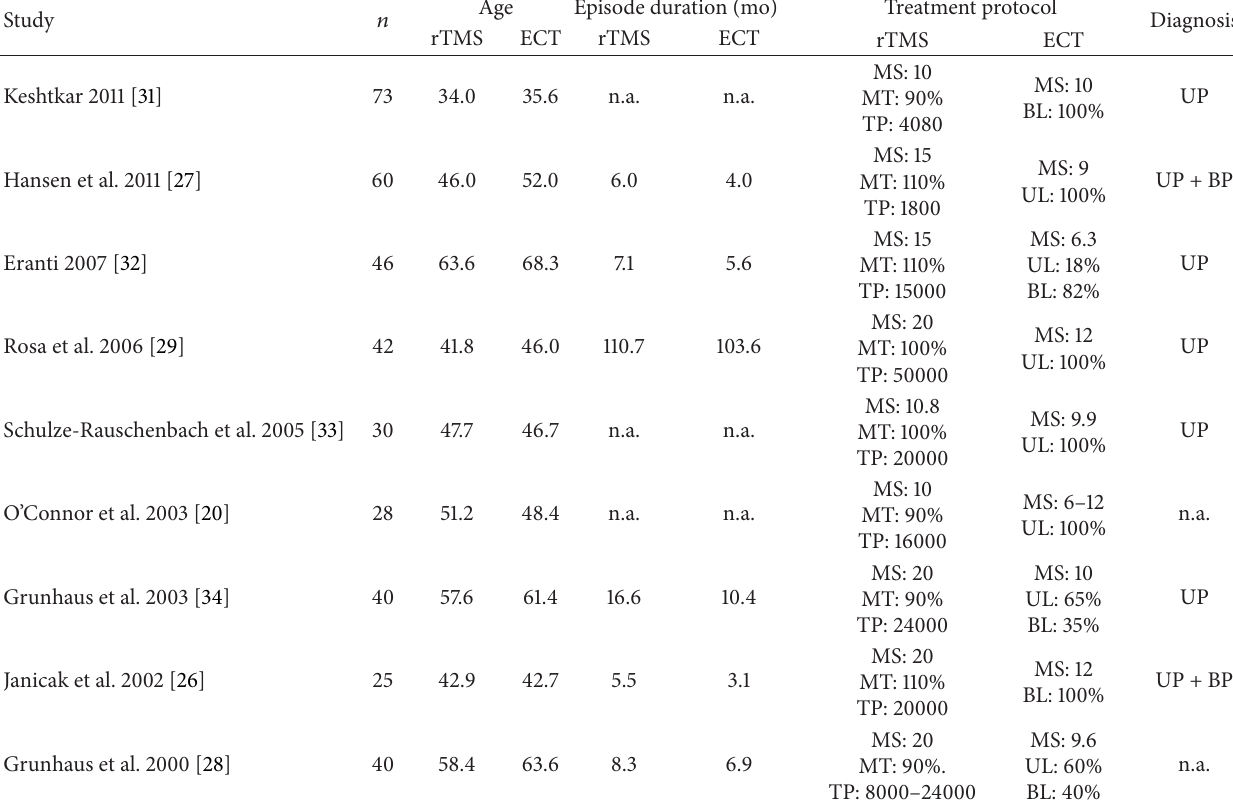
Table 1: Patient characteristics and treatment protocols.